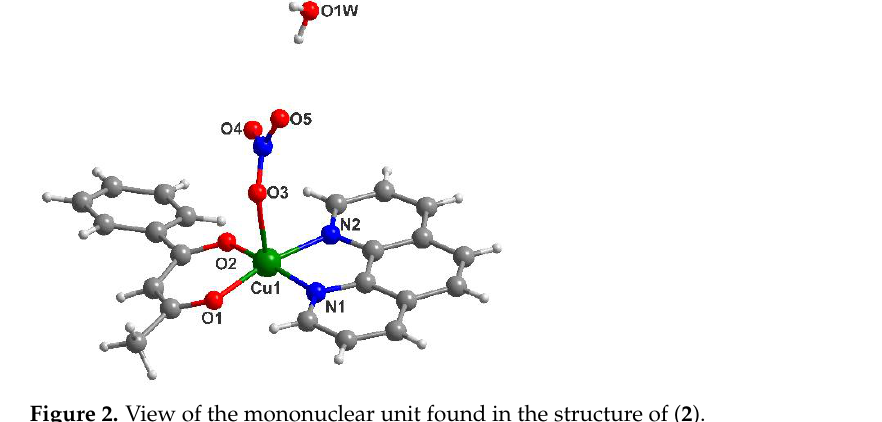
Figure 2. View of the mononuclear unit found in the structure of ( 2 ). Table 2. Selected bond lengths (Å) for compound ( 2 ).